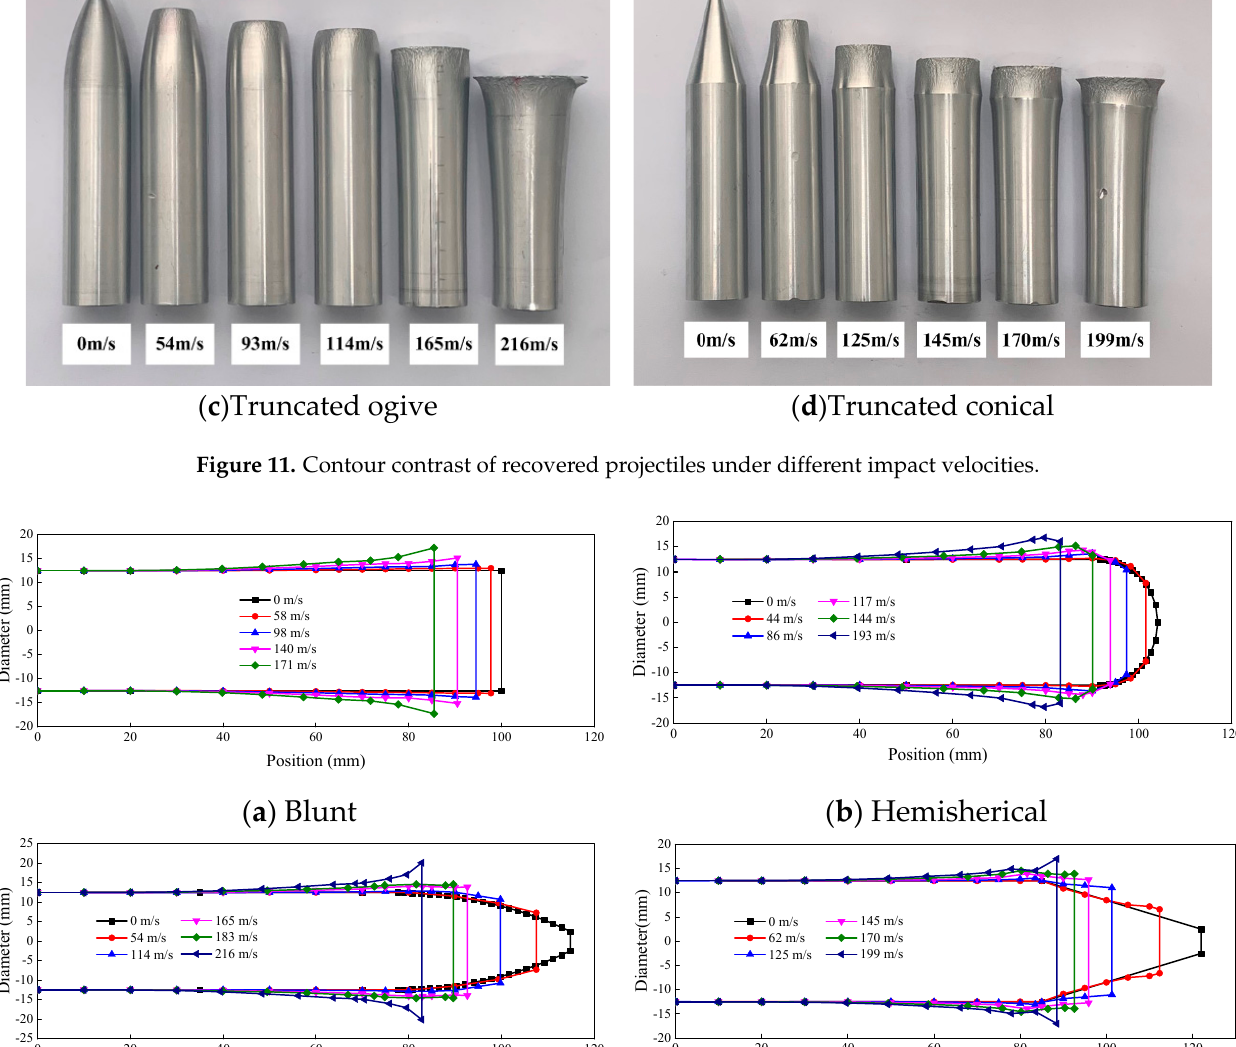
( b ) Top diameter vs. impact velocity Figure 13. Comparison of external contour changes. Figure 14 (blunt projectile with 171 m/s impact velocity) includes the incident pulse signal generated by the impact and the reflected pulse signal formed after reflection at the free end of the incident bar. No superposition of the two signals occurred, indicating that